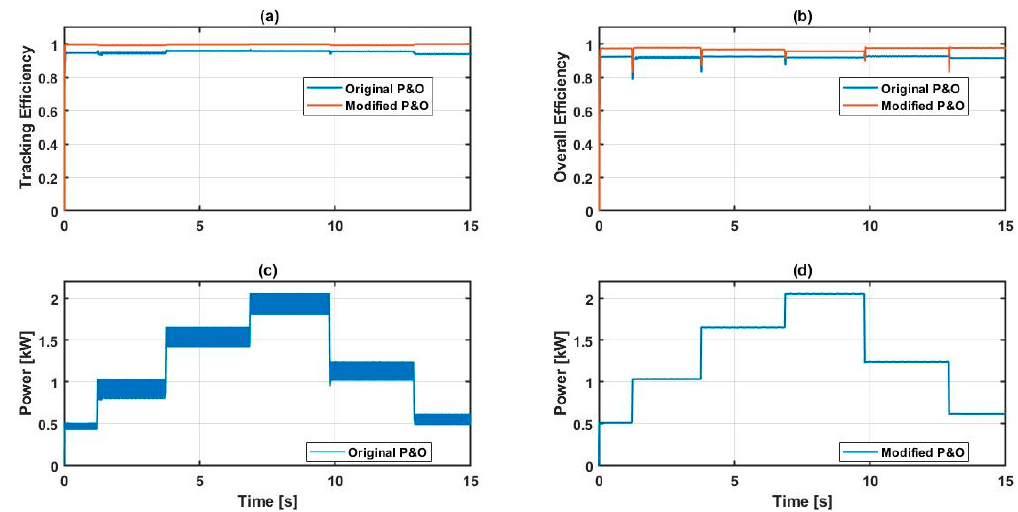
Figure 12. High-power PV system with comparison of ( a ) tracking efficiency; ( b ) overall system efficiency; ( c ) original P&O PV output power; and ( d ) modified P&O PV output power.